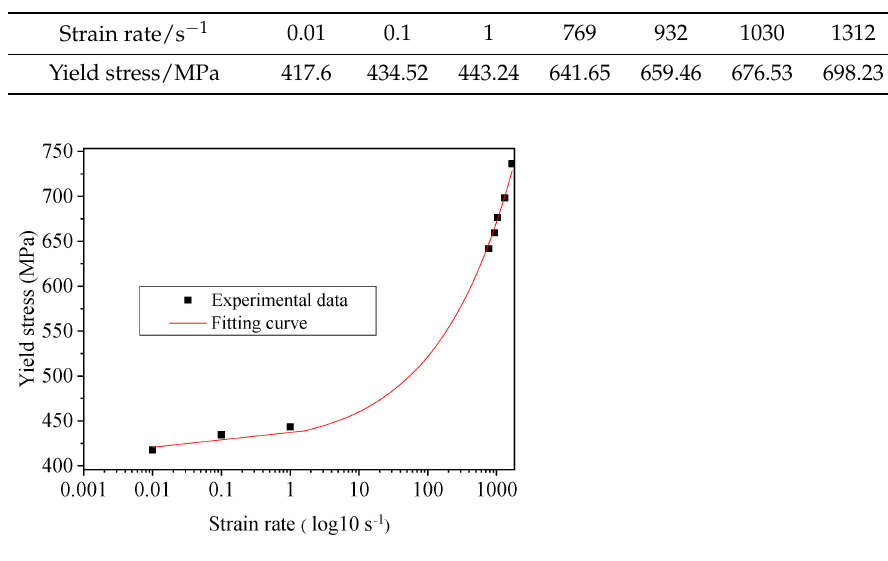
Figure 11. Variation of yield stress with strain rate.